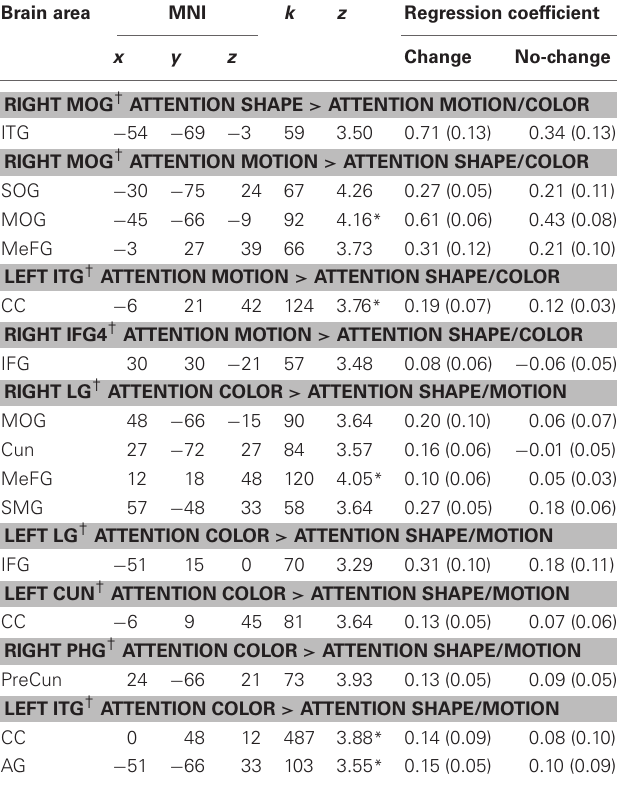
Table 6 | Target brain areas from the PPI analyses that overlapped with the functional localizers for shape (LOC), motion (MT), and color (V4). Brain area